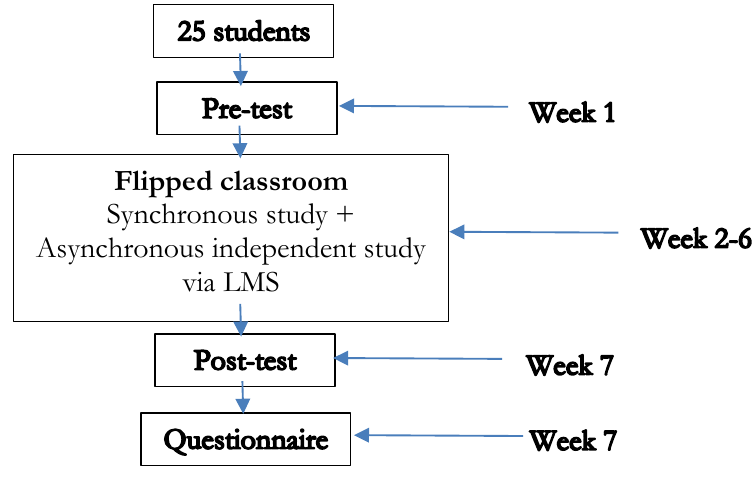
FIGURE 1. Research